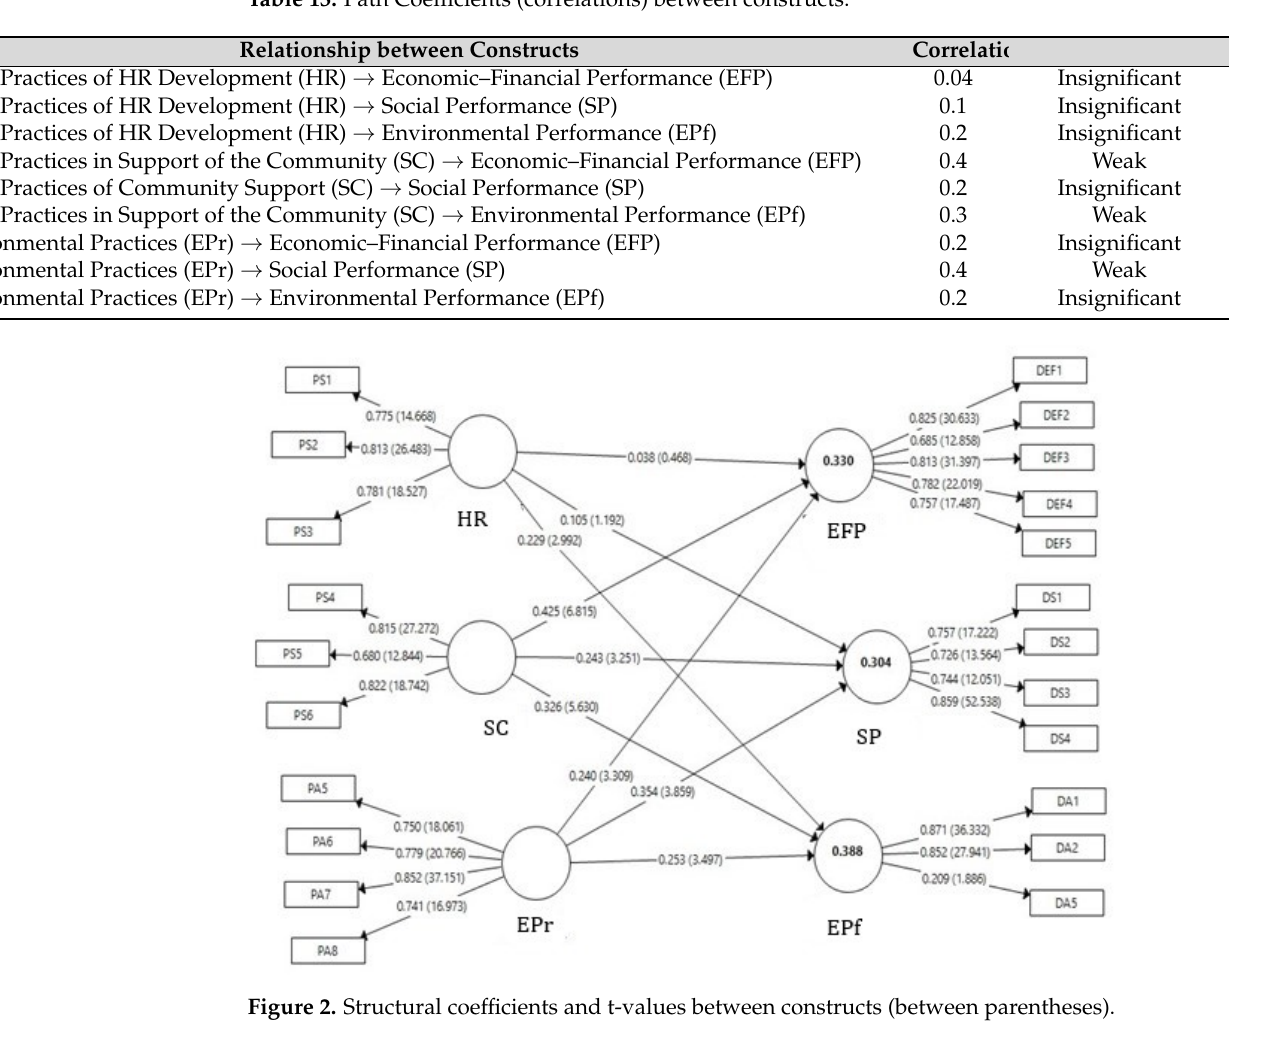
Table 13. Path Coefficients (correlations) between constructs.